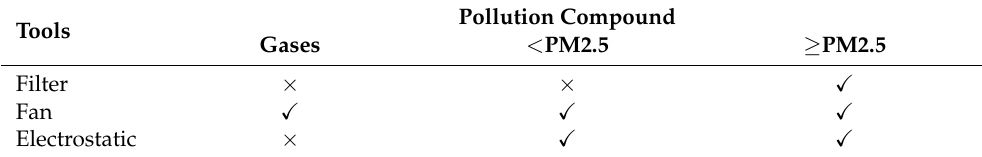
Table 1. Tools for pollution compound removal.